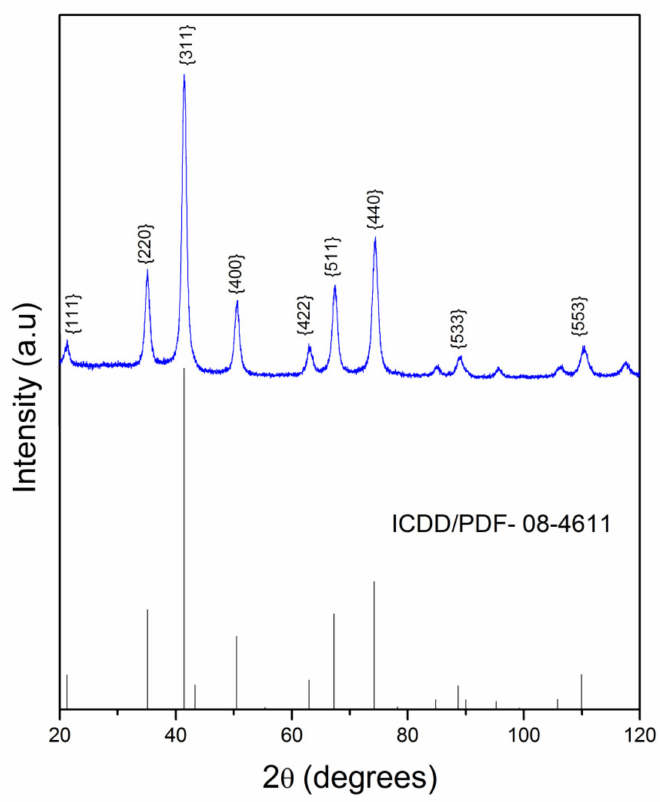
Figure 2. X-ray powder di ff raction pattern of Fe 3 O 4